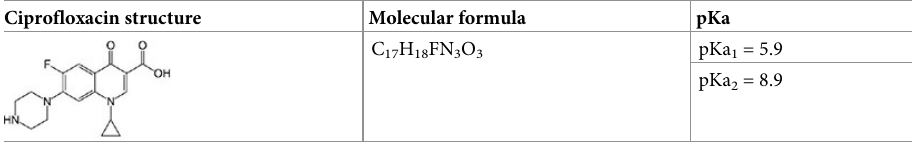
Table 6. Structural and chemical properties of ciprofloxacin and its pKa [39].